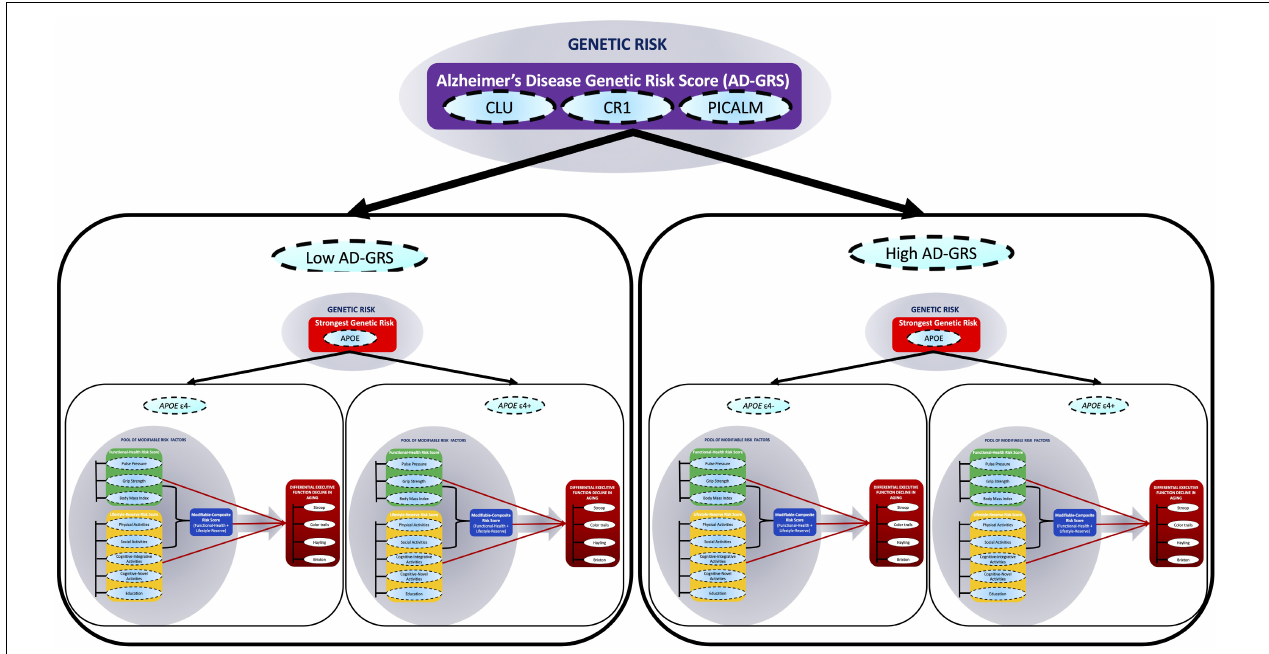
FIGURE 1 | A multimodal risk network predicts executive function (EF) trajectories in non-demented aging. In this network, we include (1) a pool of eight modifiable risk factors [pulse pressure, grip strength, body mass index, physical activities, social activity, cognitive-integrative activity, cognitive-novel activity, and education], (2) four single nucleotide polymorphisms (SNPs) ( APOE , CLU , CR1 , and PICALM ), and (3) four standard cognitive tests (Stroop, Color trails, Hayling, and Brixton). The modifiable risk factors are clustered into two main modifiable domain risk scores (functional-health and lifestyle-reserve) and a Modifiable-Composite Risk Score (M-CRS; functional-health + lifestyle-reserve). Functional-health risk score ranges from 0 to 5, lifestyle-reserve risk score ranges from 0 to 6, and the M-CRS ranges from 0 to 11. The SNPs are represented as a key AD genetic risk ( APOE ) and an Alzheimer’s disease genetic risk score (AD-GRS; CLU + CR1 + PICALM ). The cognitive tests are combined to represent EF in aging. Within this network, first, we examine whether the three modifiable domain risk scores (functional-health, lifestyle-reserve, and a M-CRS) predict differential EF decline in aging. Second, we test whether each of the three predictions are moderated (1) by a key AD genetic risk factor (stratified into APOE ε 4– versus ε 4+) and (2) further moderated by an AD-GRS (as stratified into low and high AD-GRS), to predict differential EF performance and decline in non-demented aging.